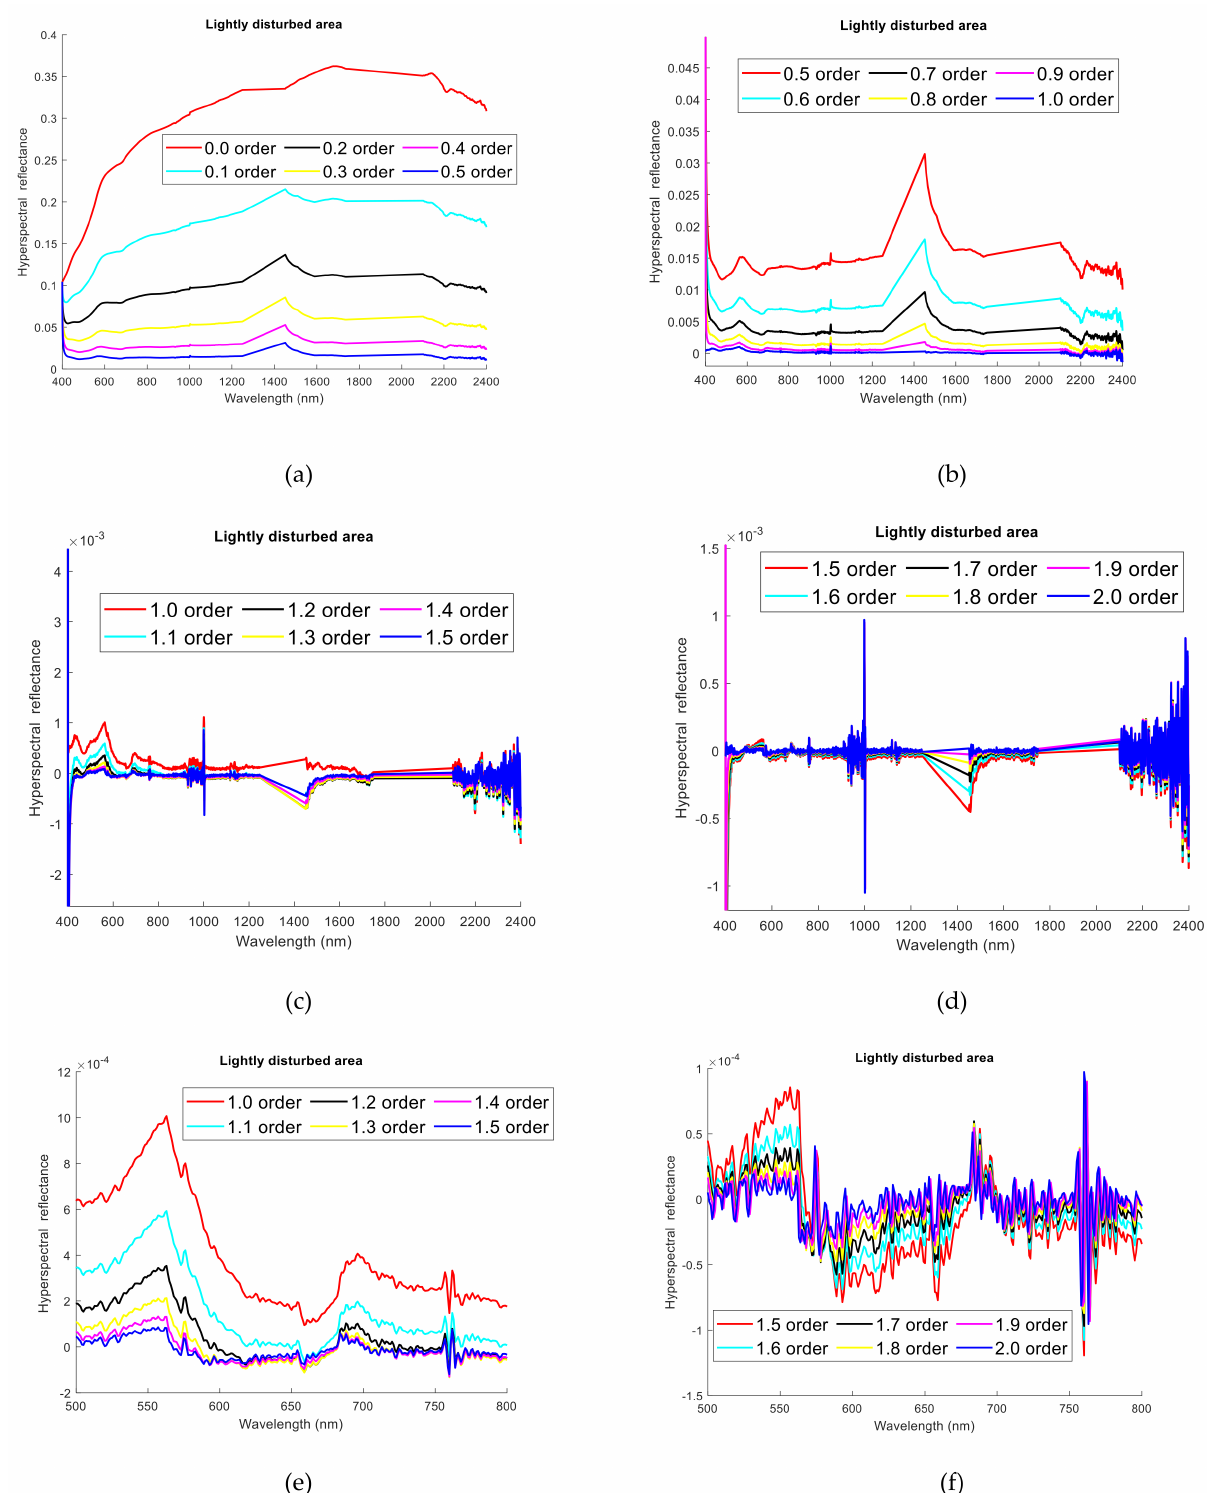
Figure 2. The reflectance curve of the soil original hyperspectral calculated by FOD in the lightly disturbed area: ( a ) 0.0-order to 0.5-order; ( b ) 0.5-order to 1.0-order; ( c ) 1.0-order to 1.5-order; ( d ) 1.5-order to 2.0-order; ( e ) 1.0-order to 1.5-order of local amplification band; ( f ) 1.5-order to 2.0-order of local amplification